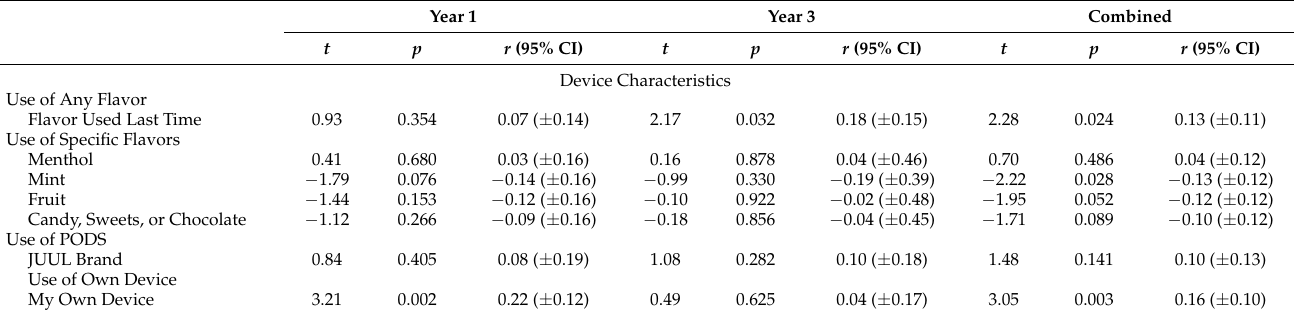
Table 3. Predictors of use occasions at years one, three, and